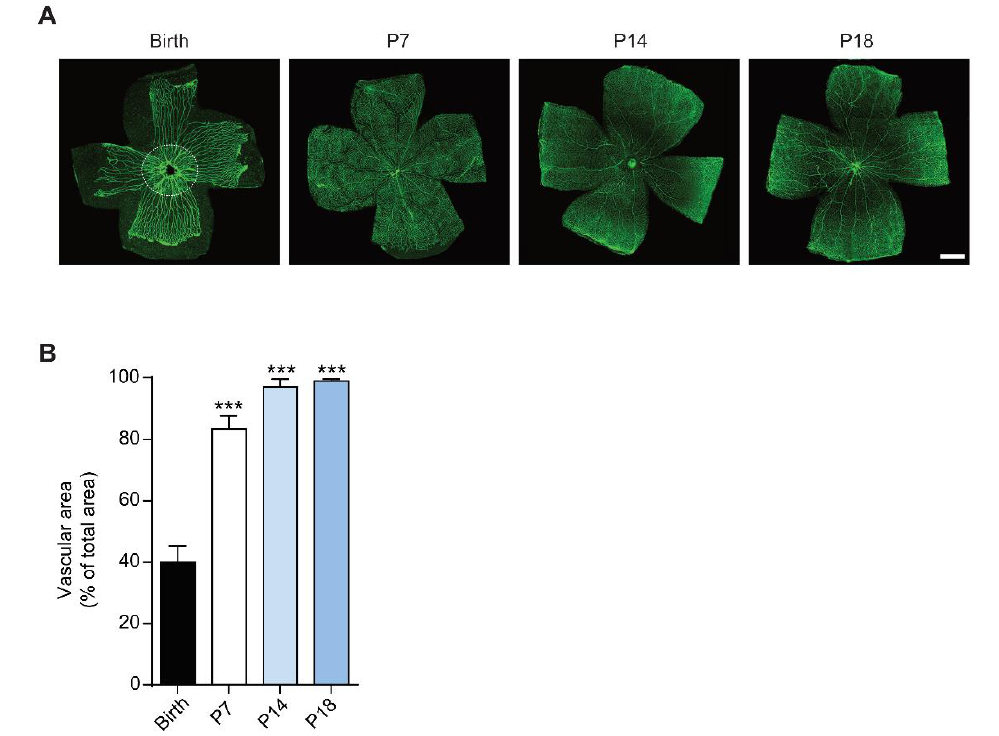
Figure 1. Development of the vascular network in rat retina. ( A ) Visualization of blood vessels by isolectin B4 staining of rat pup retinas at birth, postnatal day (P)7, P14 and P18. Dashed circle delineates the developing retinal vasculature (inner of the dashed circle) with the hyaloid vasculature (outer of the dashed circle). Scale bar = 500 µ m. ( B ) Quantitative analysis of vascular area of the retina. Data is presented as mean ± SEM. One-way ANOVA was used as statistical analysis, followed by Bonferroni’s multiple comparisons test ( n = 6; *** p < 0.001 vs birth).